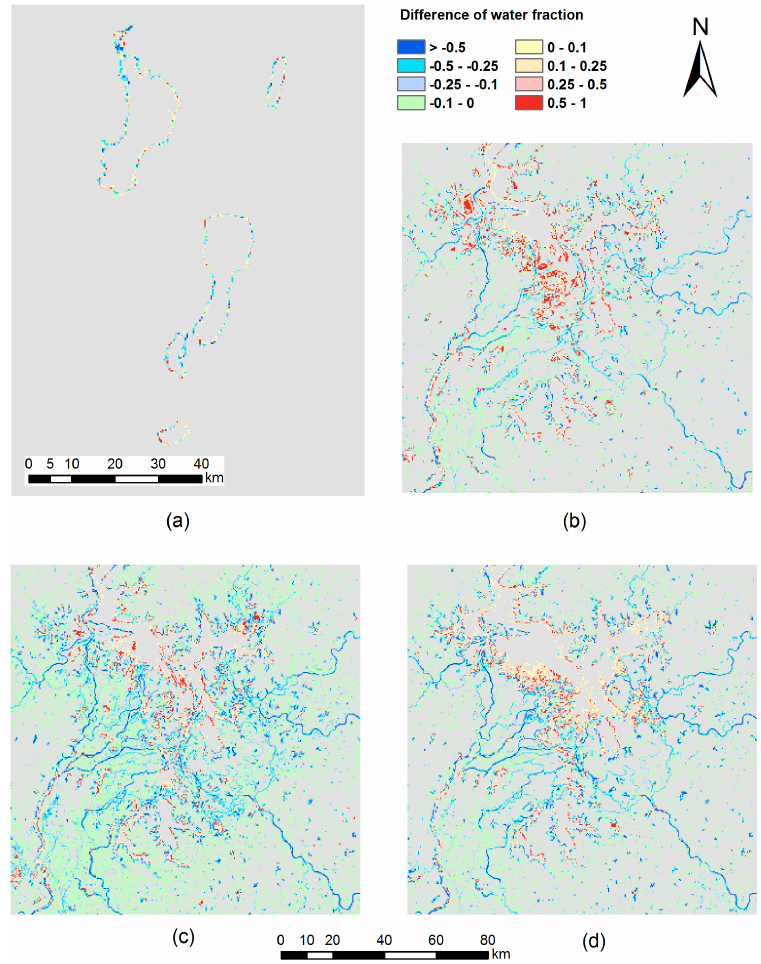
Figure 5. Difference between the NPP–VIIRS water fraction and the Landsat-simulated water fraction for the four case studies in Table 1: ( a ) Yunnan lakes; ( b ) Poyang Lake T1; ( c ) Poyang Lake T2; ( d ) Poyang Lake T3.